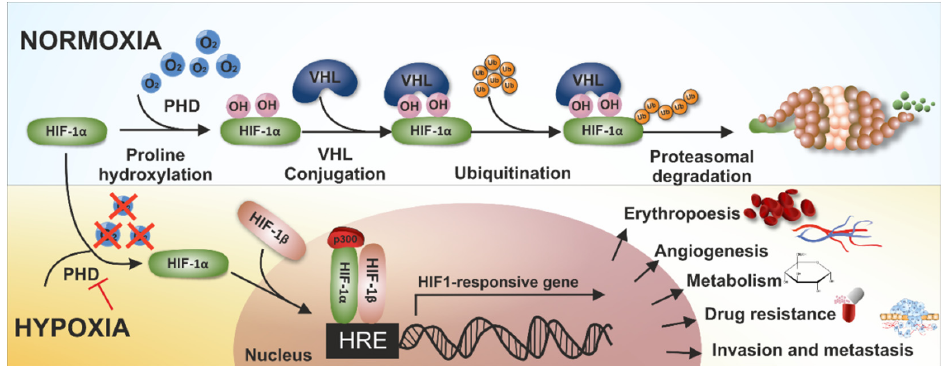
Figure 1. Mechanism of HIF-1 regulation in tumor cells.